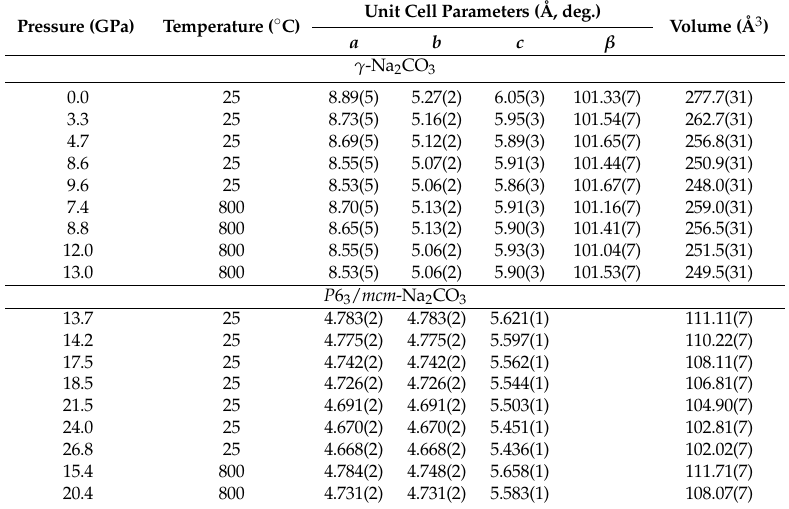
Table 2. Unit cell parameters of γ - and P 6 3 / mcm -phases of Na 2 CO 3 according to MA